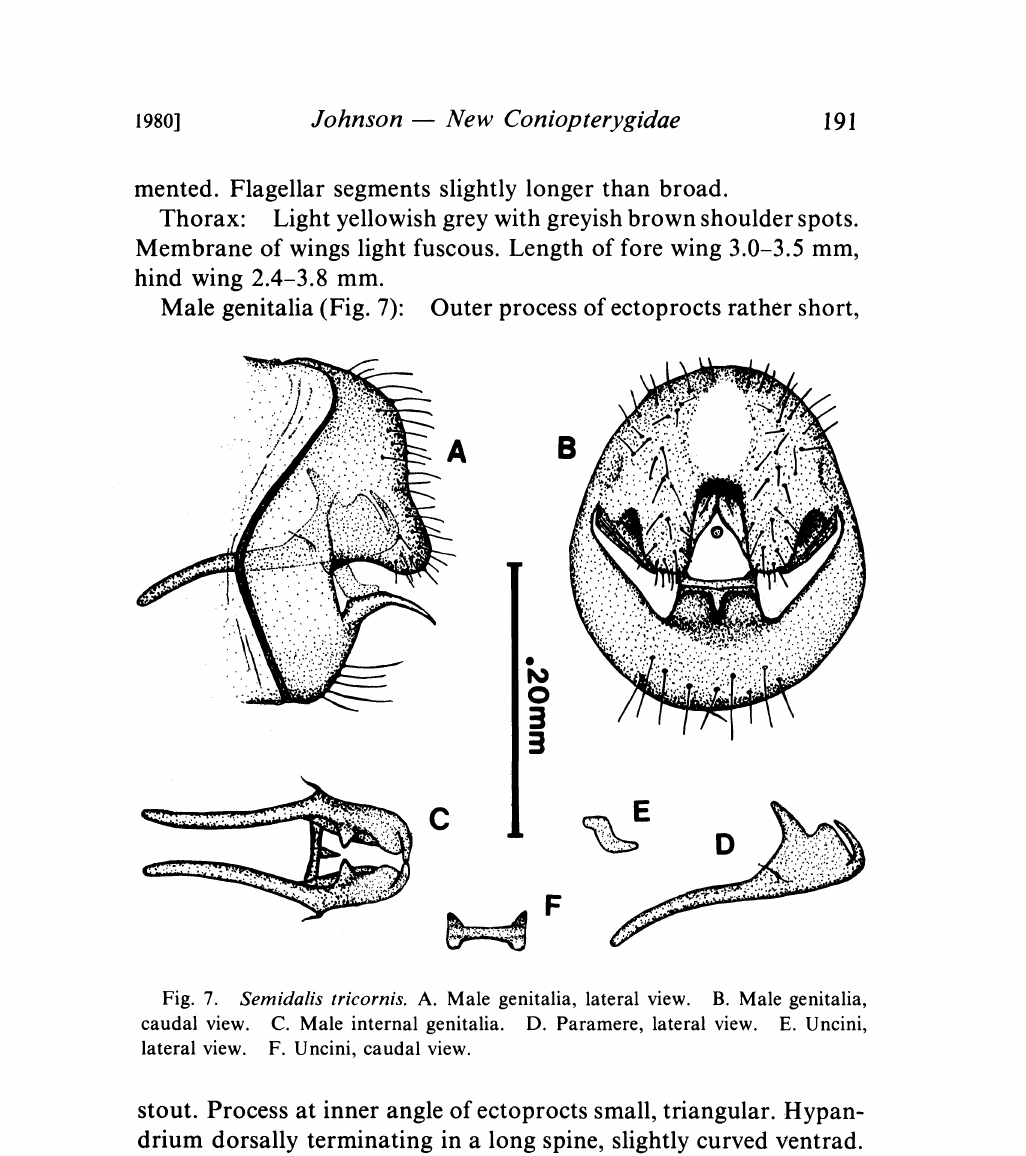
Fig. 7. Semidalis tricornis. A. Male genitalia, lateral view. B. Male genitalia, caudal view. C. Male internal genitalia. D. Paramere, lateral view. E. Uncini, lateral view. F. Uncini, caudal